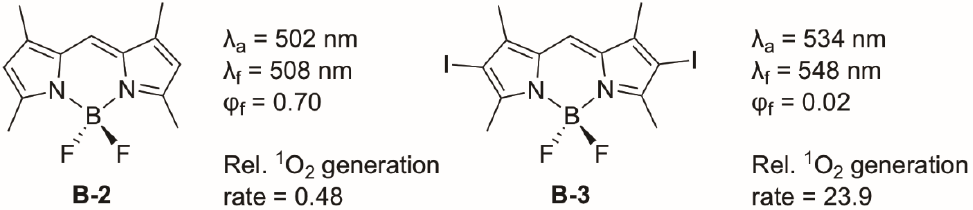
Figure 5. Change in photophysical parameters (in MeOH) for iodo-substitution at the β -positions of BODIPY B-2 [55]. 1 O 2 generation rate was determined relative to methylene blue.